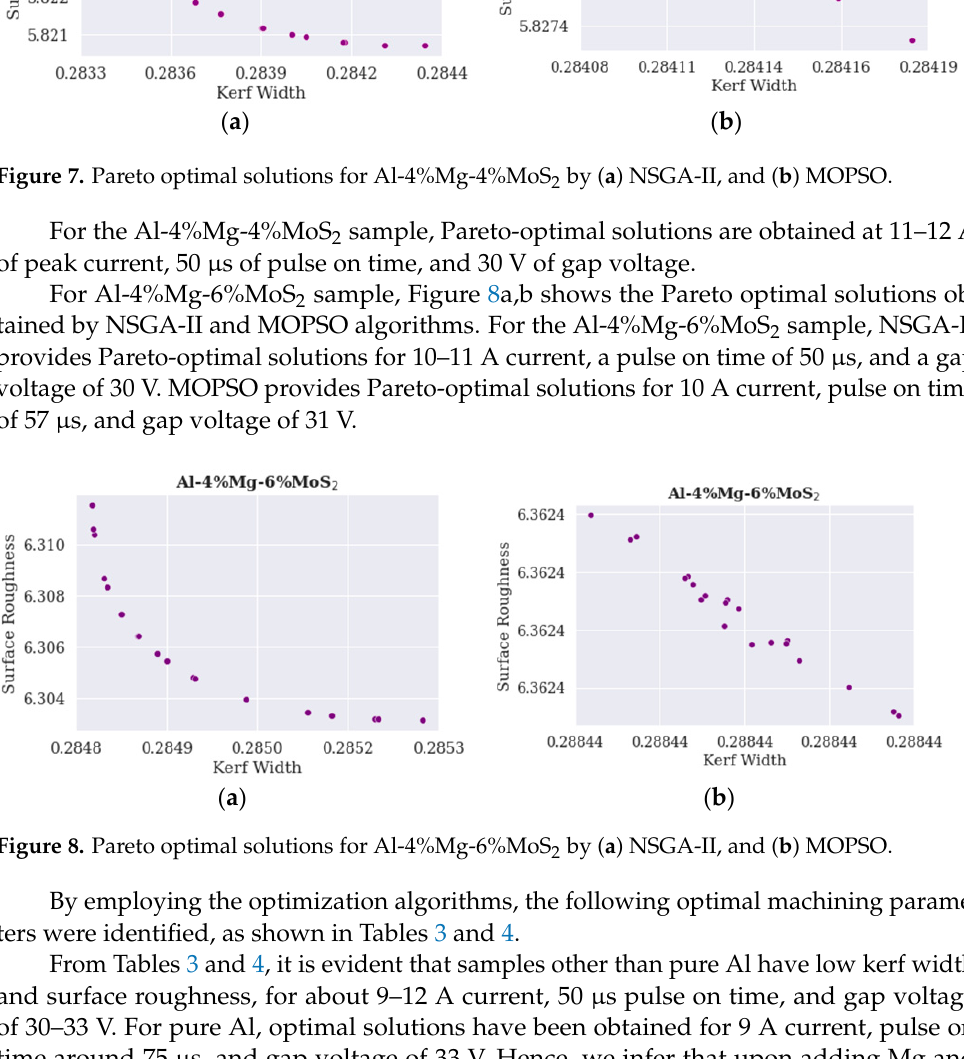
Figure 8. Pareto optimal solutions for Al-4%Mg-6%MoS 2 by (a) NSGA-II, and (b) MOPSO.